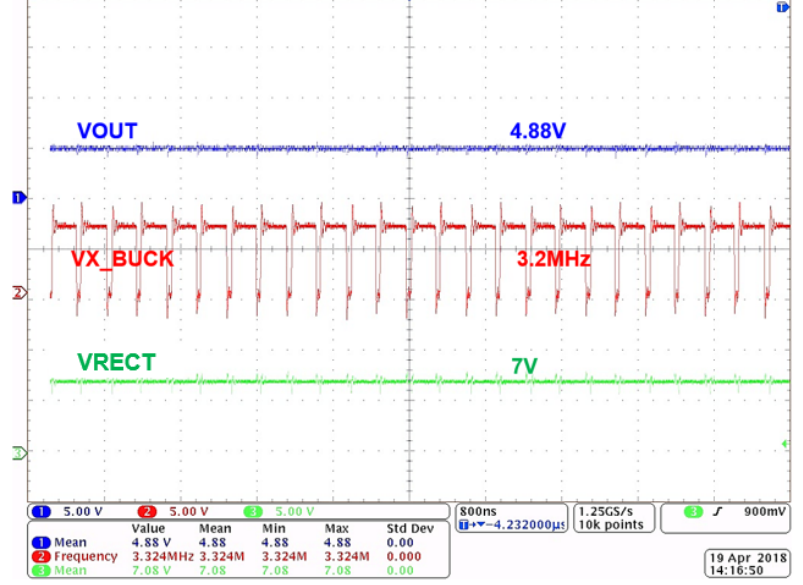
Figure 14. Measured results of the RF EH harvester.